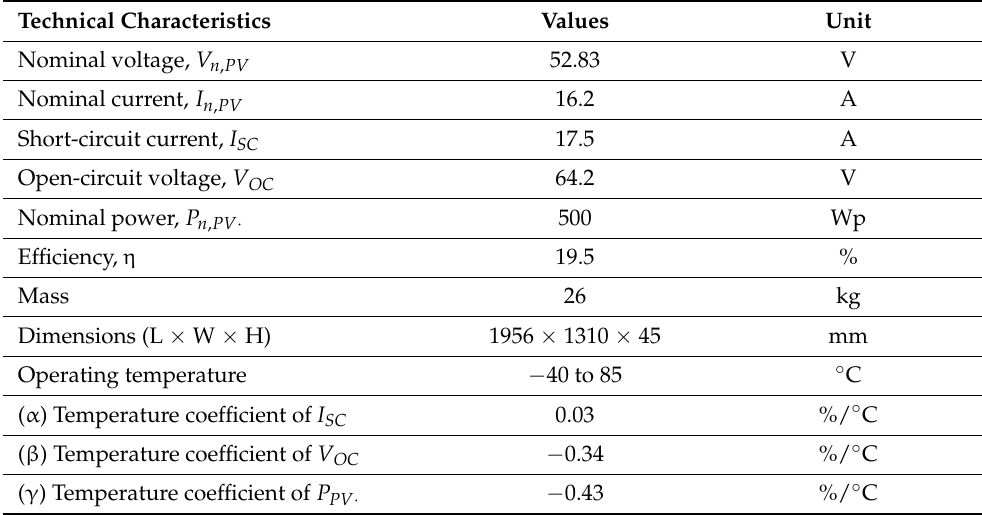
Table A1. Technical characteristics of photovoltaic panel type SIV SERIES 535W monocrystalline